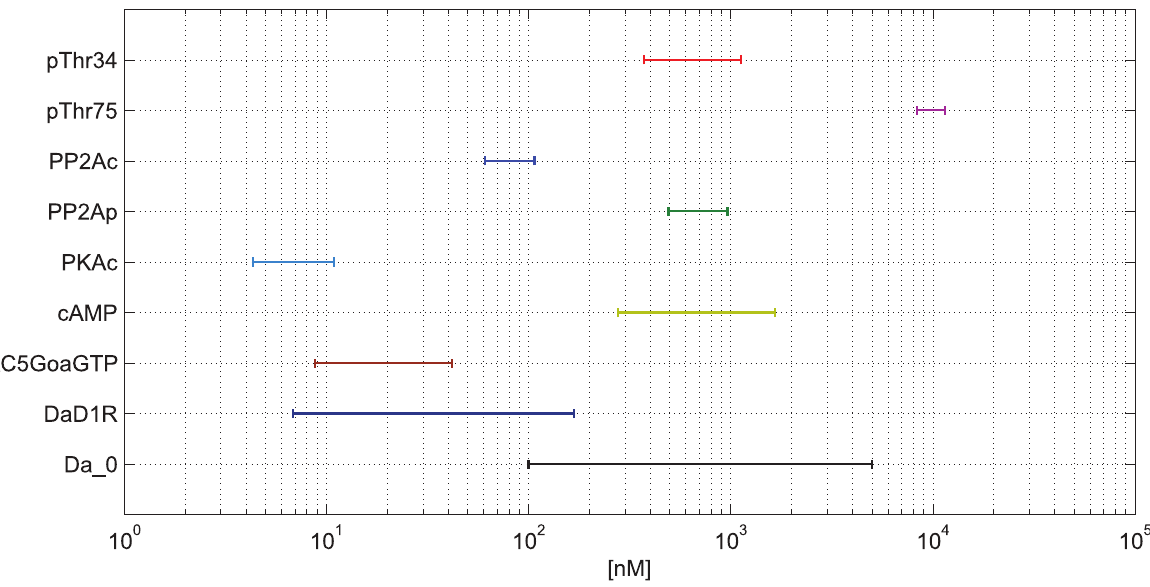
Figure 3. Ranges of Concentrations in Response to Input (Da). For a number of relevant target species from the biological model, the range of concentrations for input (Da) from 100 nM to 5 m M is shown (Ca - high, 8 m M).